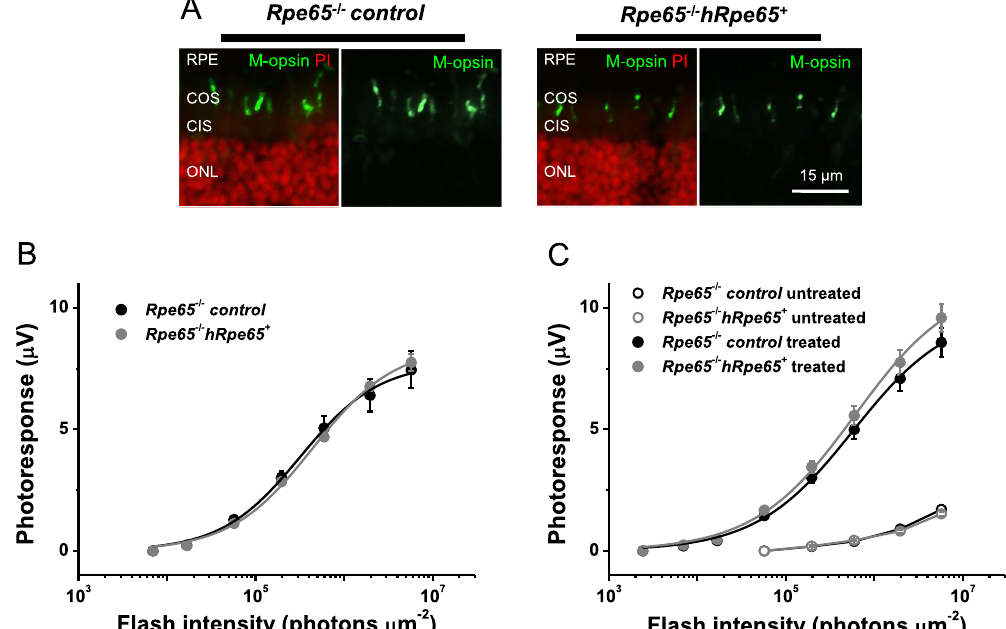
Figure 8. Transgenic expression of human RPE65 in M-cones of RPE65-deficient mice does not improve their morphology or function. ( A ) Comparable cone density and morphology in retinas of control Rpe65 − / − Gnat1 − / − (left) and transgenic Rpe65 − / − Gnat1 − / − hRpe65 + (right) mice. M-opsin expression in dorsal retina was examined by immunostaining with rabbit M-opsin antibody (green). Cell nuclei were stained with propidium iodate (red). RPE: retinal pigmented epithelium; COS: cone outer segments; CIS: cone inner segments; ONL: outer nuclear layer. Scale bar, 15 μ m. ( B ) Averaged cone intensity-response functions (mean ± SEM, no statistical significance at any point) for control (n = 4) and transgenic (n = 6) retinas treated acutely with exogenous 9- cis -retinal. Hyperbolic fits yielded half-saturating intensities ( I 1/2 ) of 3.2 × 10 5 and 4.4 × 10 5 photons μ m − 2 for control and transgenic animals, correspondingly. Mice were raised in normal light/dark cycling conditions before retina isolation and chromophore treatment. ( C ) Averaged cone intensity-response functions (mean ± SEM, no statistical significance at any light intensity) for untreated animals (open symbols) or dark-reared mice repeatedly injected with 9- cis -retinal and Matrigel (closed symbols). Control (untreated, n = 8; treated, n = 16), transgenic (untreated, n = 8; treated, n = 17). Hyperbolic fits yielded I 1/2 -values of 5.8 × 10 5 and 6.1 × 10 5 photons μ m − 2 for chromophore-treated control and transgenic animals, respectively. Because of their small values, data for untreated mice (open symbols) were not fitted with Naka-Rushton functions and connected with straight lines instead. Error bars for some points in ( C ) are smaller than the symbol